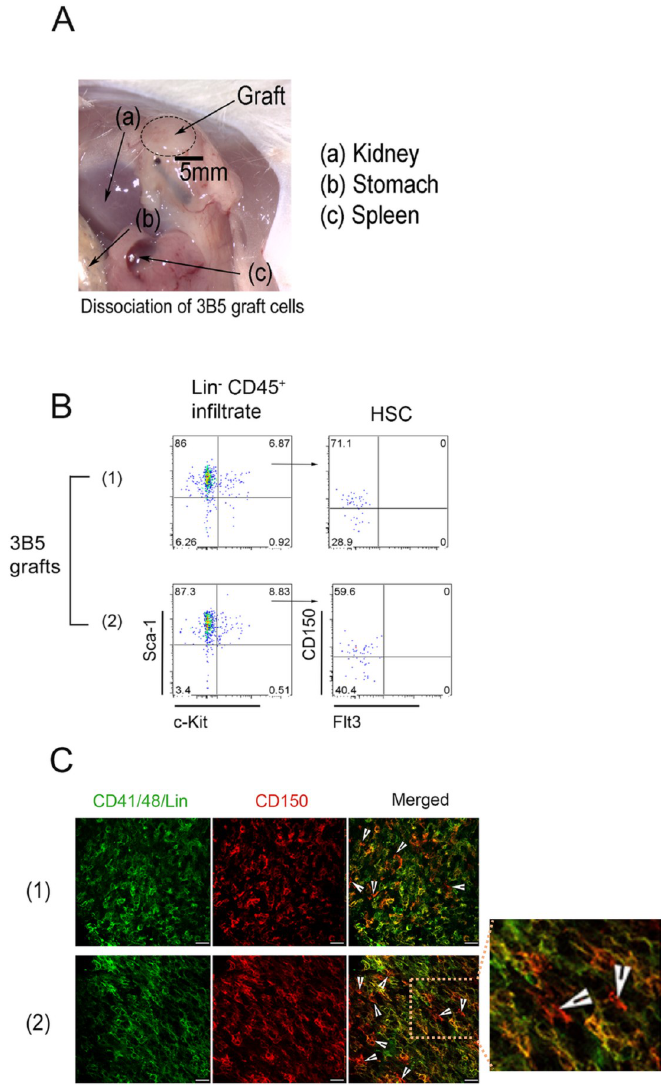
Fig 6. Detection of hematopoietic stem/progenitor cells in ectopic grafts. (A) Grafts of 3B5 stroma were prepared as described in Fig 5. (B) Grafts were dissociated and analysed flow cytometrically to distinguish hematopoietic cells of NOD/SCID host origin (CD45.1). Non-hematopoietic (including 3B5 stromal cells) were gated or excluded from analysis. Hematopoietic stem/progenitor cells were then identified as the lineage-negative (Lin - ) subset. Further staining for stem cell markers cKit, Sca1, CD150 and Flt3 was used to identify HSCs in the graft as Lin - cKit + Sca1 + CD150 + Flt3 - cells. (C) Frozen sections from two separate grafts were stained for CD150 (red) and Lin/ CD41/CD48 (green). Arrows identify HSPCs as Lin - CD41/48 - CD150 + cells. Bar represents 25um.